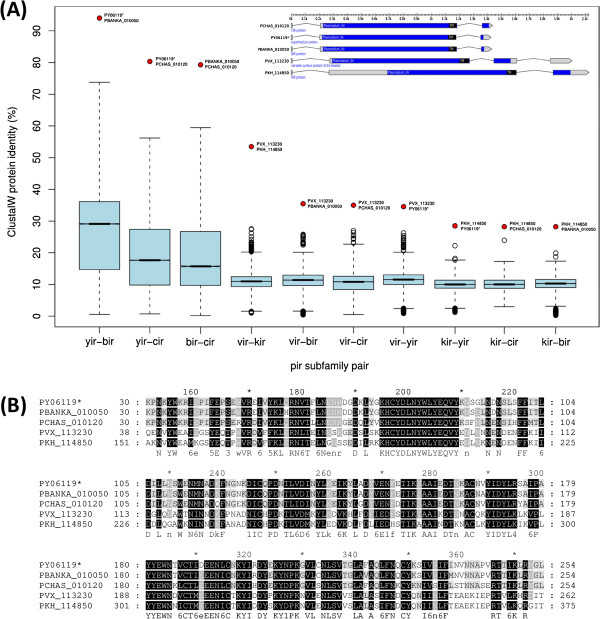
Identification of ultra-conserved PIR orthologs. (A) PIR protein sequences from five Plasmodium species, including P. yoelii (826 yir genes), P. berghei (135 bir genes), P. chabaudi (196 cir genes), P. vivax (345 vir genes), and P. knowlesi (68 kir genes), were globally aligned in an all-vs.-all pairwise manner using ClustalW. Box plots show the resulting distribution of global percent identity values for each pair of species. For each species pair, one outlier (red circles) representing a pair of proteins with increased cross-species conservation levels is identified, including PY06119 (P. yoelii), PBANKA_010050 (P. berghei), PCHAS_010120 (P. chabaudi), PVX_113230 (P. vivax), and PKH_114850 (P. knowlesi). The inset shows the gene models of these five proteins with the predicted Plasmodium_vir domain (PF05795) indicated in blue and predicted transmembrane domains (TM) indicated in black. The second exon of PY06119 was found to be truncated and an improved version of this gene model (PY06119*) was therefore used in the analysis. (B) Multiple sequence alignment of the five conserved PIR orthologs. Note the exceptional high degree of sequence conservation (indicated by black and gray columns), suggesting an important molecular function for this particular PIR protein in each Plasmodium species.